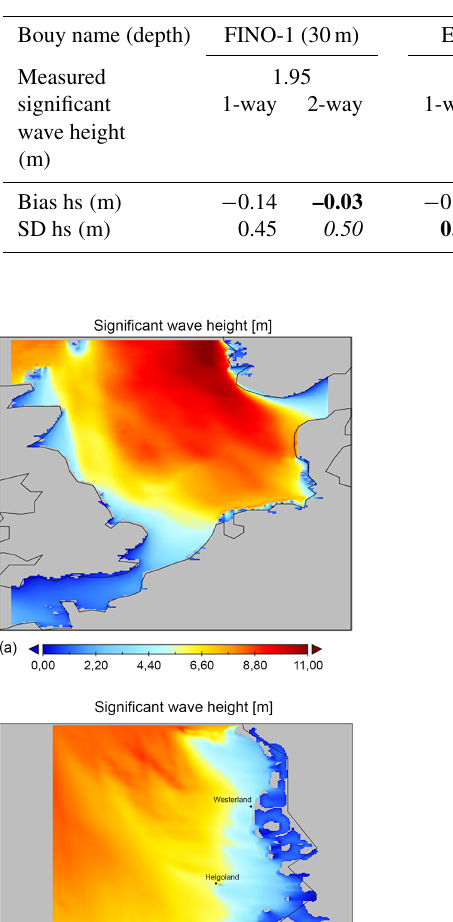
Table 3. Significant wave height (m) bias and standard deviation of the one- and two-way coupled WAM German Bight model data against the available buoy data over the whole period (measured minus modelled). Bold means an improvement of the two-way coupled model skills; italic means that the one-way coupled model skill is better than the ones of the two-way coupled model.